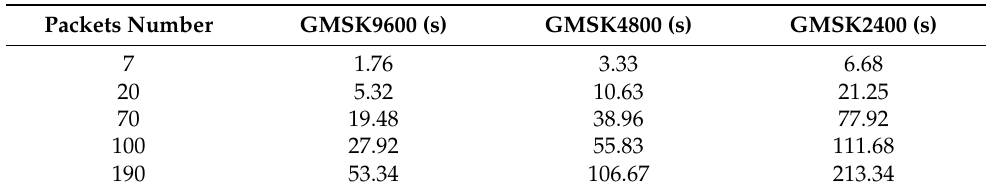
Table 3. The time needed to receive data in different patch sizes in the three available modes of the design.